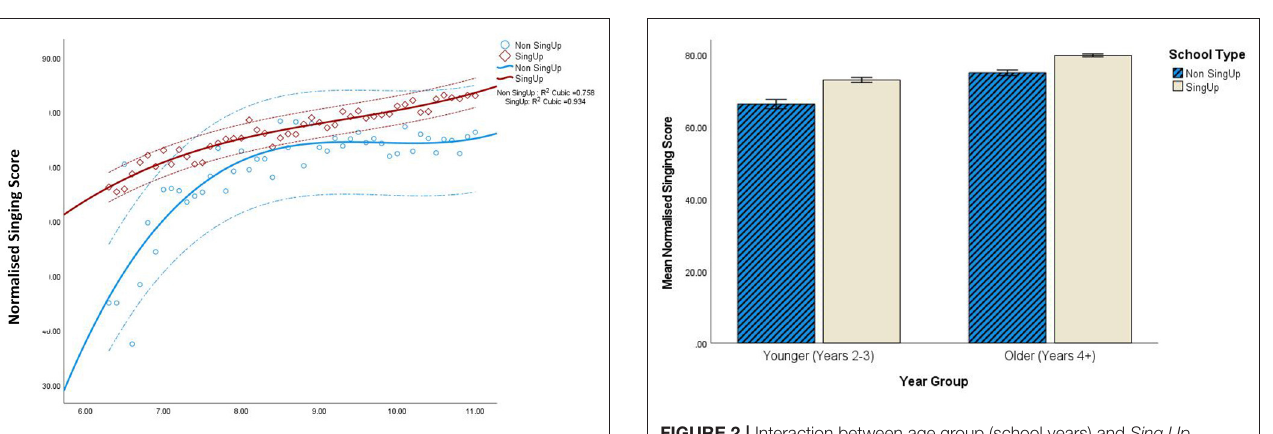
FIGURE 2 | Interaction between age group (school years) and Sing Up participation in terms of normalized singing